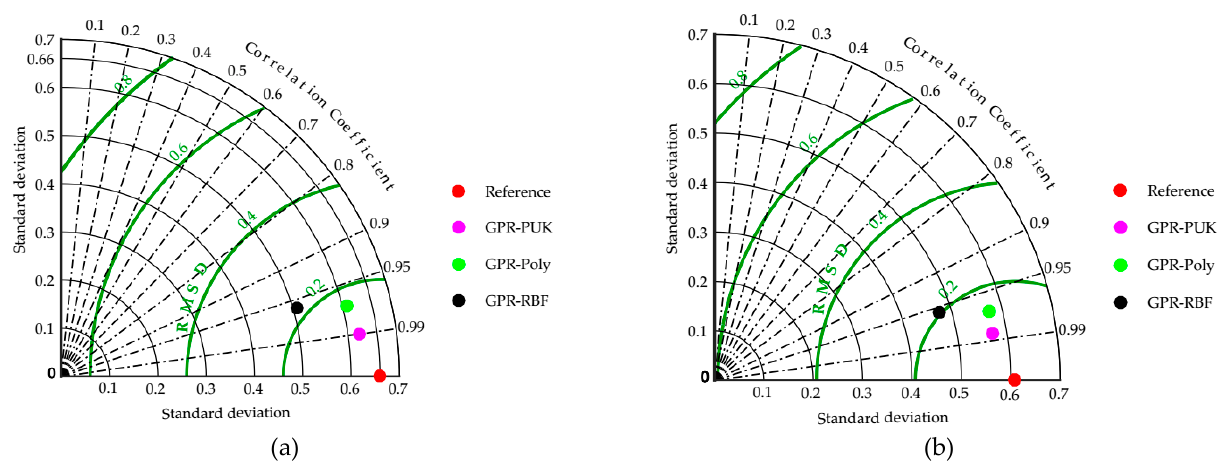
Figure 5. Taylor diagram for ( a ) training dataset ( b ) testing dataset, comparing all the models proposed in the present study.